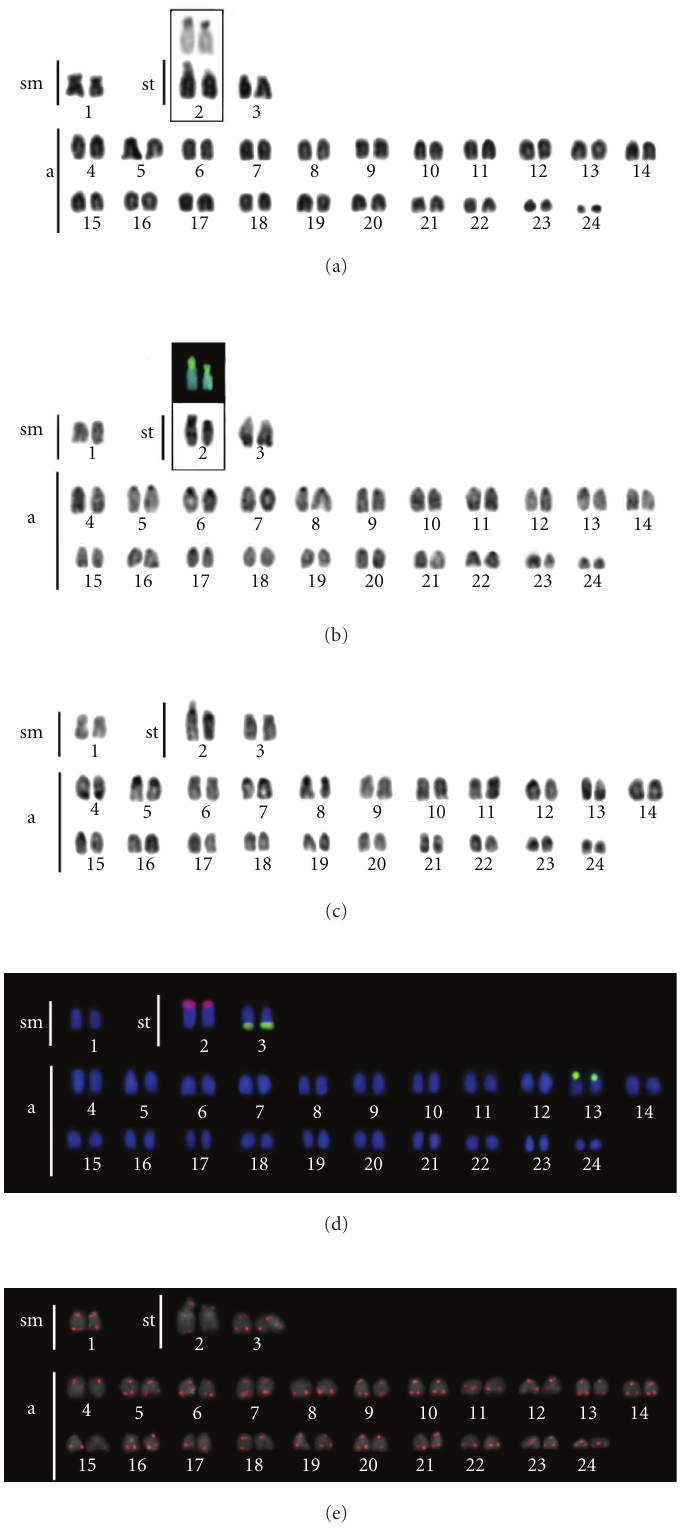
Figure 1: Karyotypes of Rachycentron canadum. Conventional staining (a) highlighting the Ag-NOR sites in chromosome 2; (b) C-banding, highlighting the NORs as CMA + 3 /DAPI − heterochromatic regions; (c) replication bands, showing 18S (pair 2) and 5S (pairs 3 and 13) rDNA sites with early replication; (d) double - FISH with 18S (pink) and 5S (green) rDNA probes, showing the location of 18S rDNA sites in pair 2 and of 5S rDNA sites in pairs 3 and 13; (e) FISH with (TTAGGG) n sequences showing the location of telomeric sites in the chromosomes (orange). Bar = 5 μ